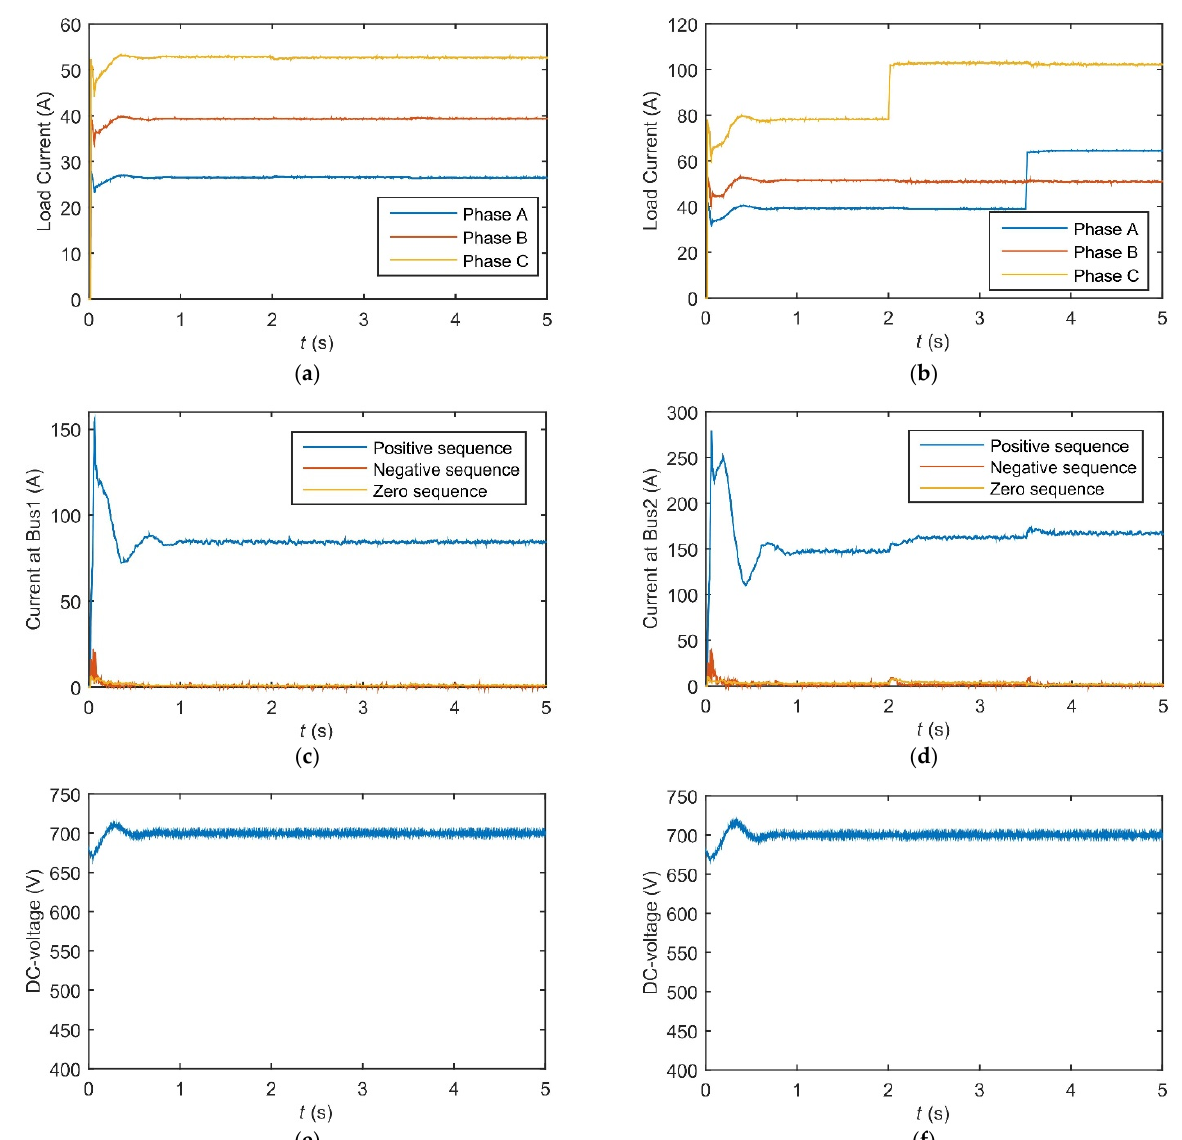
Figure 9. The single-line diagram of the tested LVDN with imbalanced single-phase loads.